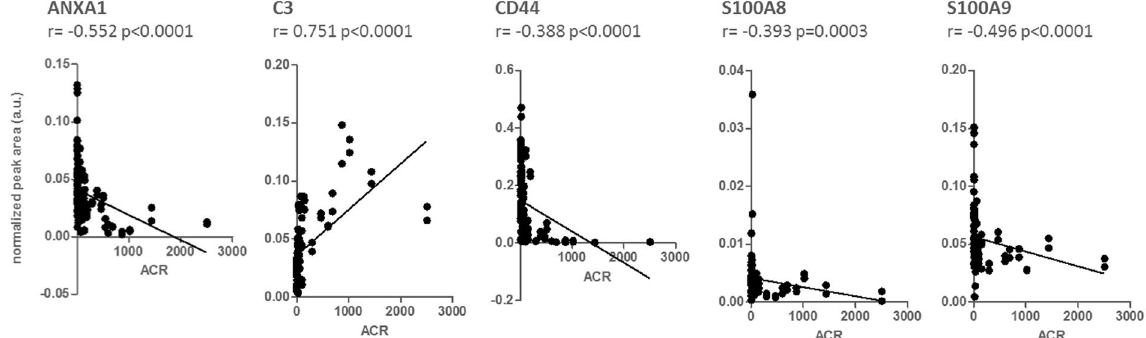
Figure 6. Graphs show correlations (Spearman correlation) between confirmed proteins and ACR (albumin to creatinine ratio).